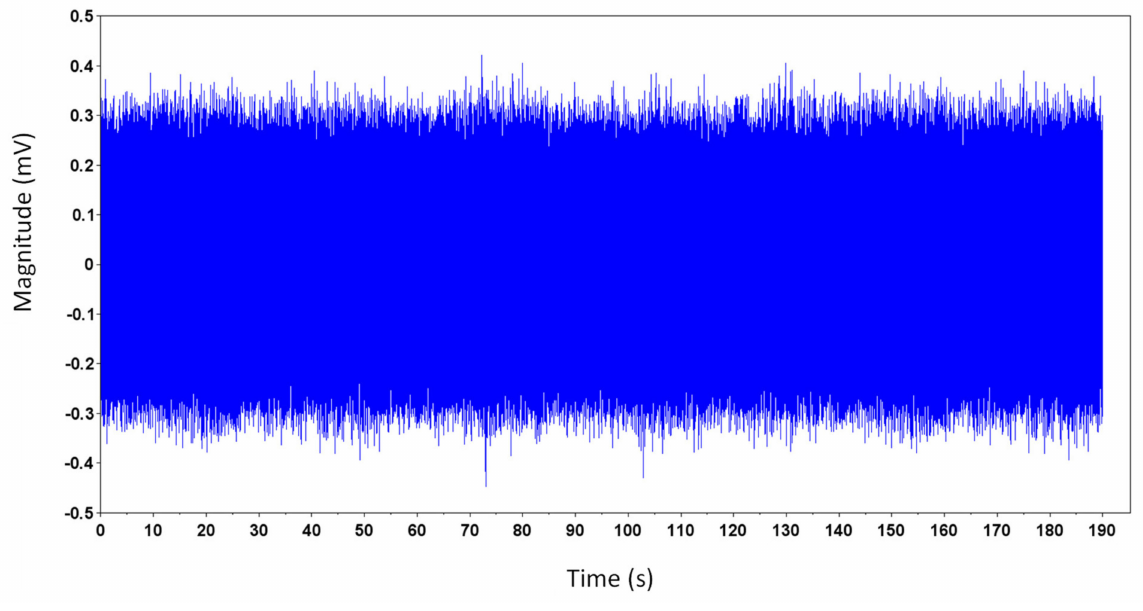
Figure 2. Time-domain signal.